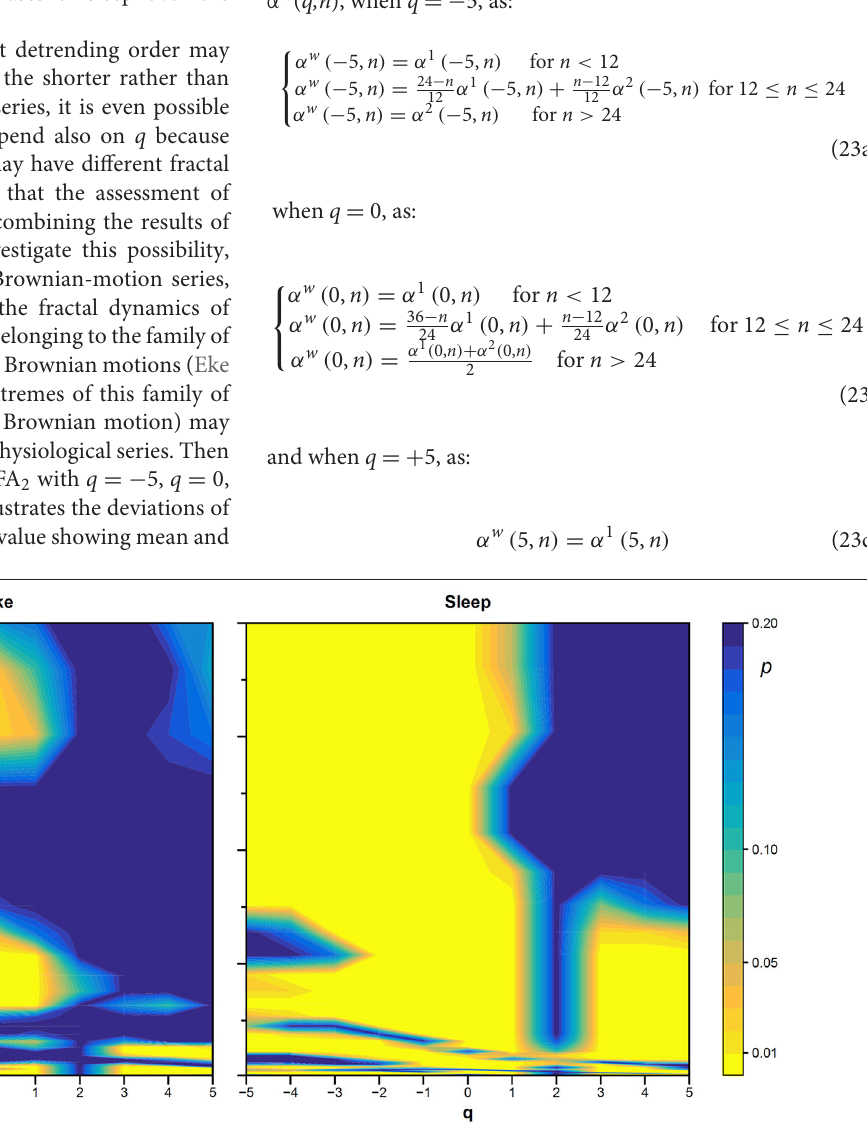
Frontiers in Physiology |